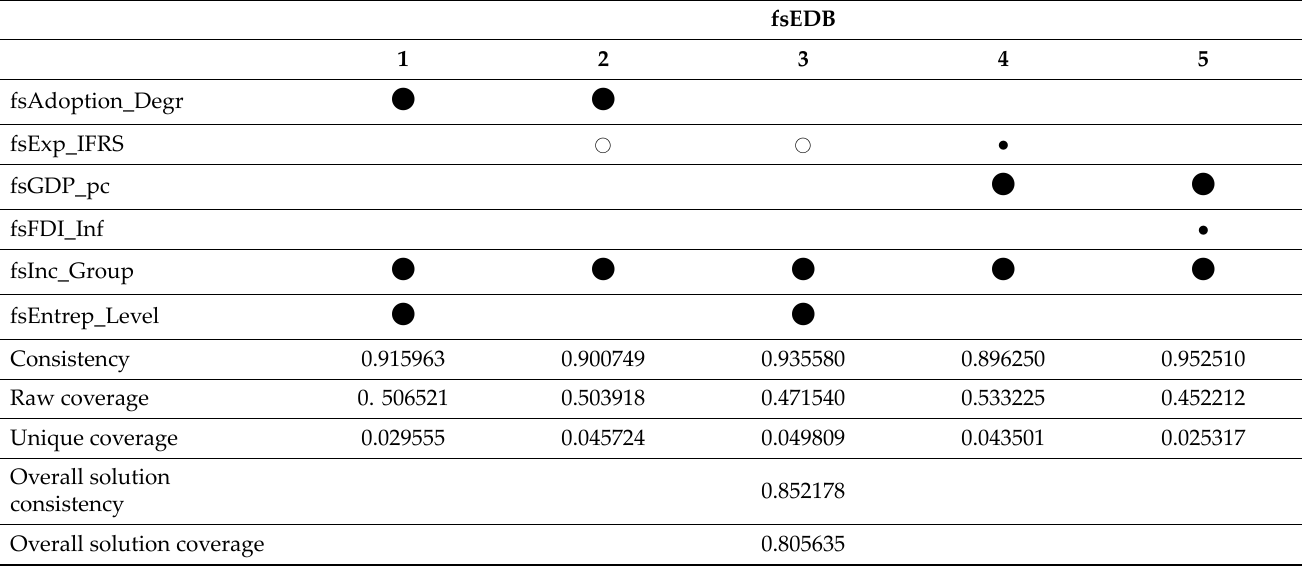
Table 8. Solution from fsQCA: configurations for achieving high GC scores — Model 2a . fsGC